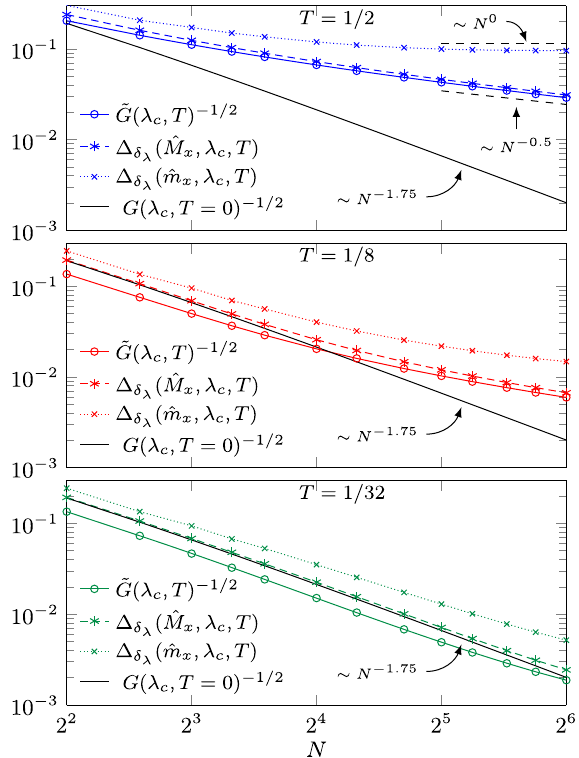
FIG. 5. The crossover between different scaling limits when the temperature T is nonzero. Results obtained by comparing states at equilibrium. For given small T we recover the apparent super- Heisenberg scaling when N is small enough, or alternatively, for T ≪ N − z=d . In the opposite limit, when the system size is further ˜ ð ˆ M G ð λ ; T Þ − 1 = 2 and Δ δ ; λ ; T Þ have increased and NT d=z ≫ 1 , c x c λ a crossover to the classical N − 1 = 2 dependence, however, with the prefactors that are enhanced by the presence of a quantum critical ð ˆ m ; λ ; T Þ saturates and becomes independent point at T ¼ 0 . Δ δ x λ on the system size in that limit. Similarly as in Fig. 4, we observe ð ˆ H λ ; T Þ is closely following the optimal bound set by that Δ δ 1 ; λ ˜ G ð λ ; T Þ − 1 = 2 plotted here QFI even at nonzero temperatures. c is a lower bound of the (inverse of the square root of) ˜ G ð λ ; T Þ − 1 = 2 and Fisher information, which lies between c ð ˜ G ð λ ; T Þ = 2 Þ − 1 = 2 ; see text for discussion. Solid lines show the c corresponding ultimate bound for T ¼ 0 from Fig. 1. Dashed lines indicate various scalings and serve as guidance for the eye. ¼ 0 Results for J z